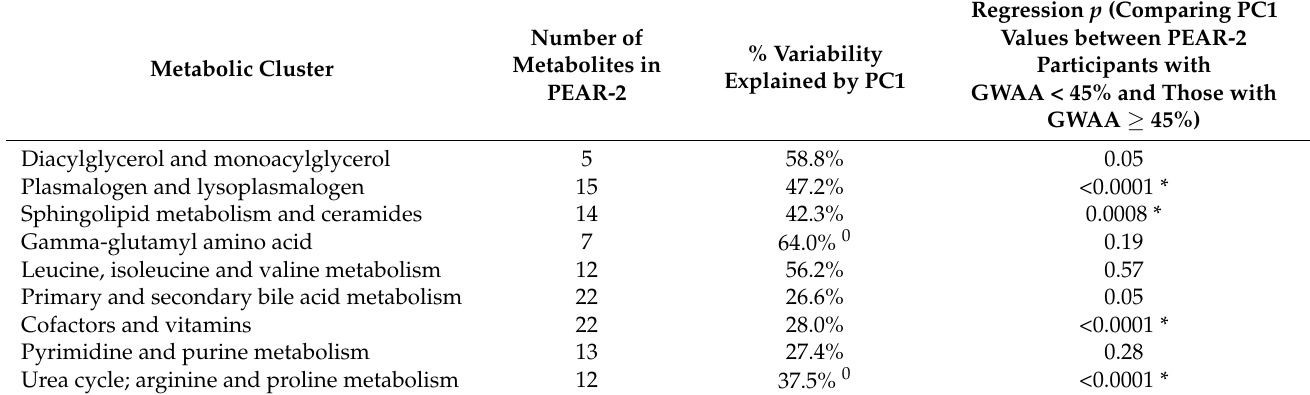
Table 3. Results of the cluster analysis conducted using the PEAR-2 replication cohort on the 13 metabolic